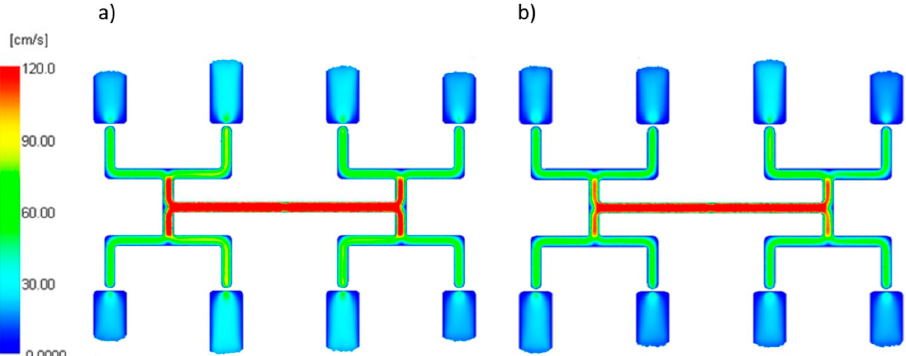
Figure 15. An effect of the power law index n on the mass filling imbalance factor I m at various injection rates (Low = 5 cm 3 /s, High = 500 cm 3 /s).